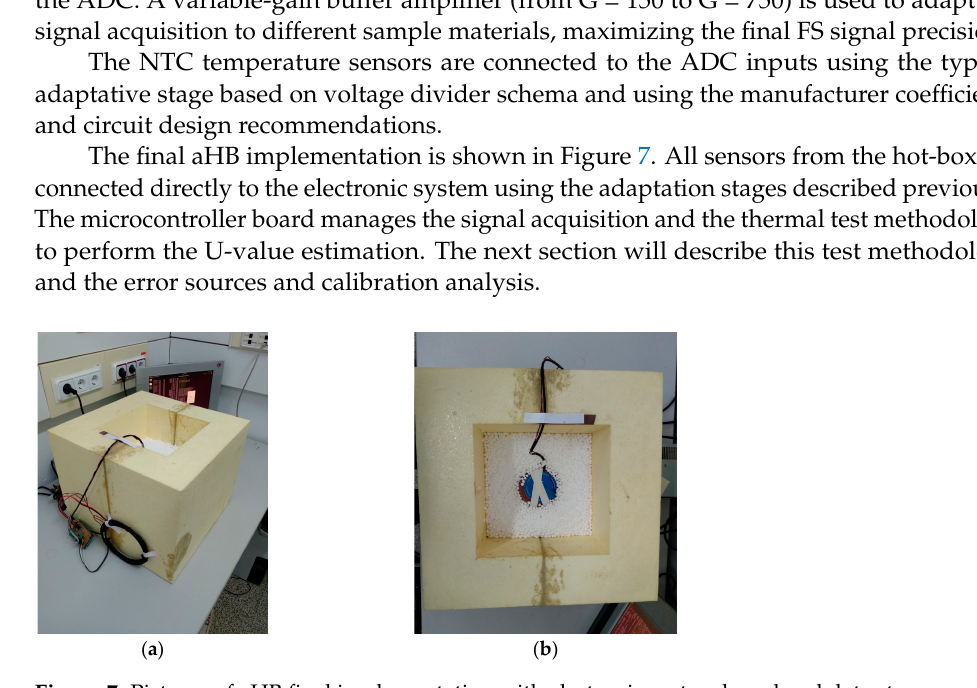
Figure 7. Pictures of aHB final implementation with electronic system board and data storage server: ( a ) lateral view of aHB with electronic boards; ( b ) top view of aHB with thermal flux on top of a material sample.